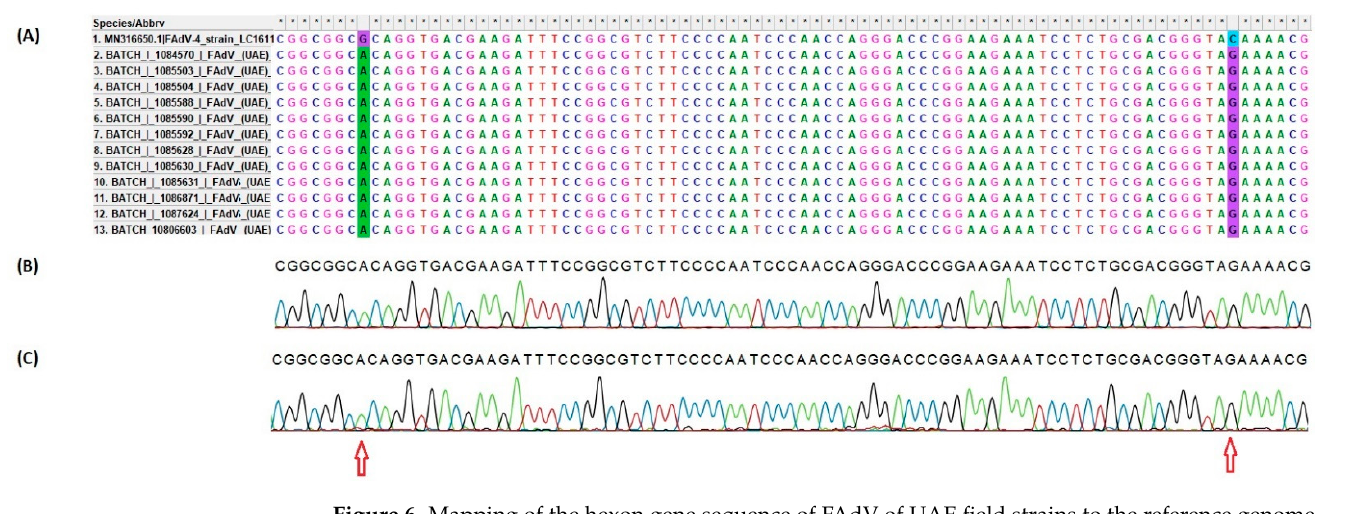
Figure 5. Real-time PCR amplification curves. Melting curve of the amplified FAdV-4 hexon gene from infected chickens tested tissue specimens (heart, spleen, kidney or liver). The arrows indicate positive control (+Ve CL) and negative control ( − Ve CL). The qPCR was performed with Light- Cycler ® 2.0 Instrument.